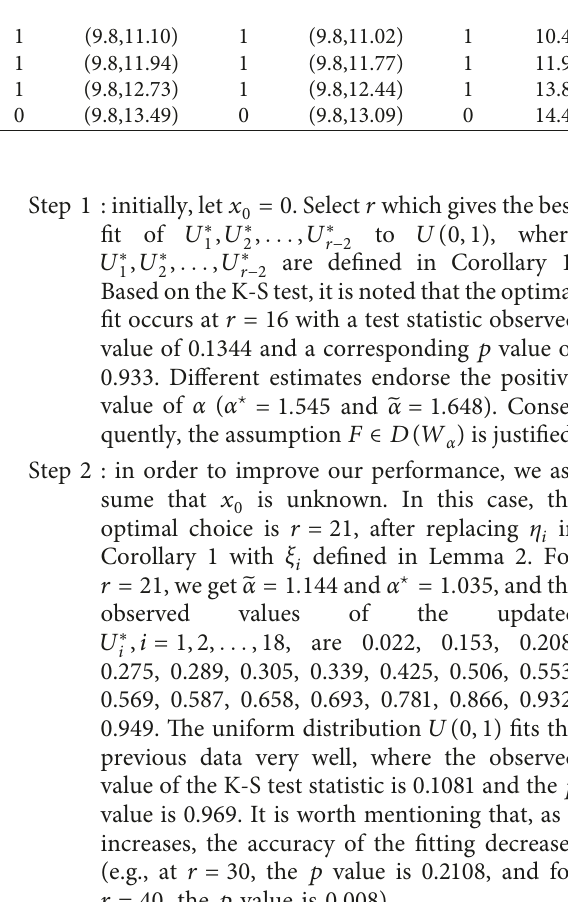
Table 6: Ninety five percentage predictive intervals of the failure times x r � 16 , 21, and 26. ( L,Us R